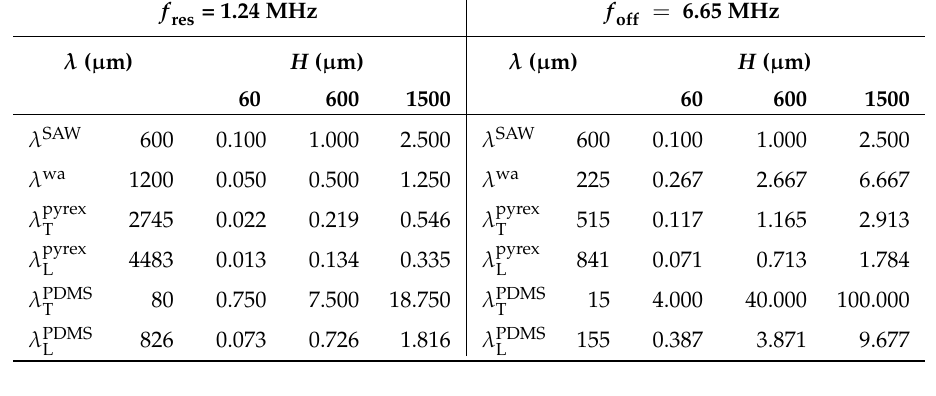
Table 1. The ratio H / λ for various values of the material thickness H and the different acoustic wavelengths λ present in the system at the two frequencies f res and f off .